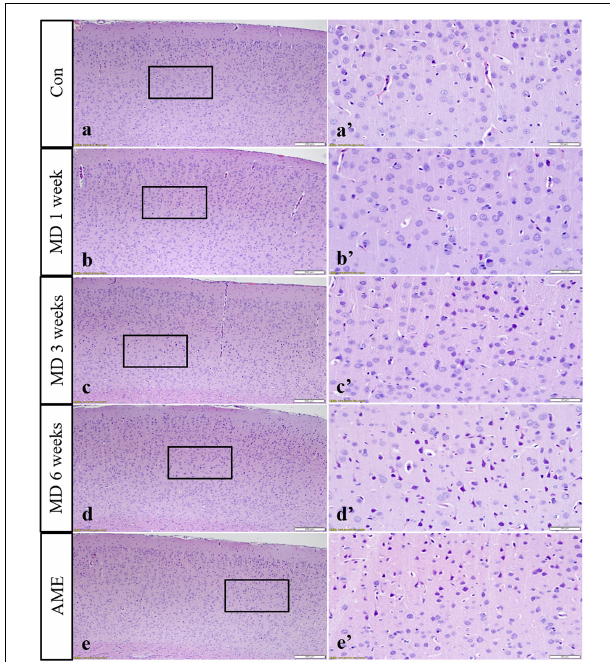
FIGURE 2 | Hematoxylin staining of the cortex. Panels (a’–e’) are magnified areas of panels (a–e) , respectively. With increasing periods of morphine dependence, gaps around the small blood vessels and neurons widened, and microglia hyperplasia. Bars = 200 µ m in panels (a–e) . Bars = 50 µ m in panels (a’–e’) ; MD, morphine dependence; AME, acute morphine exposure.